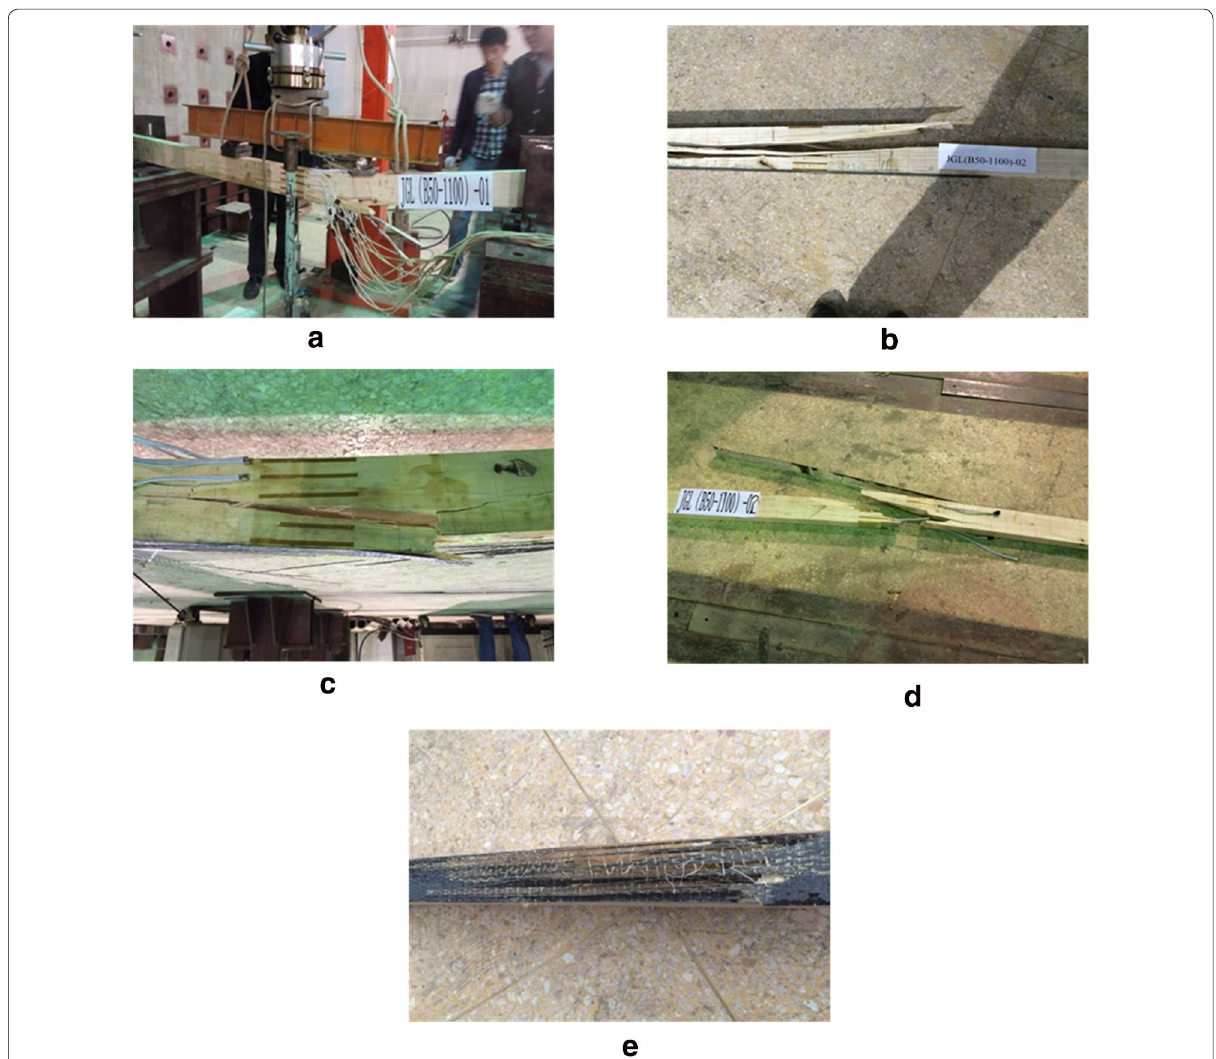
Fig. 7 Typical failure of tested beams: a for JGL(B50-1100)-01; b for JGL(B50-1100)-02; c for JGL(B50-1700)-01; d for JGL(B50-1700)-02; e for